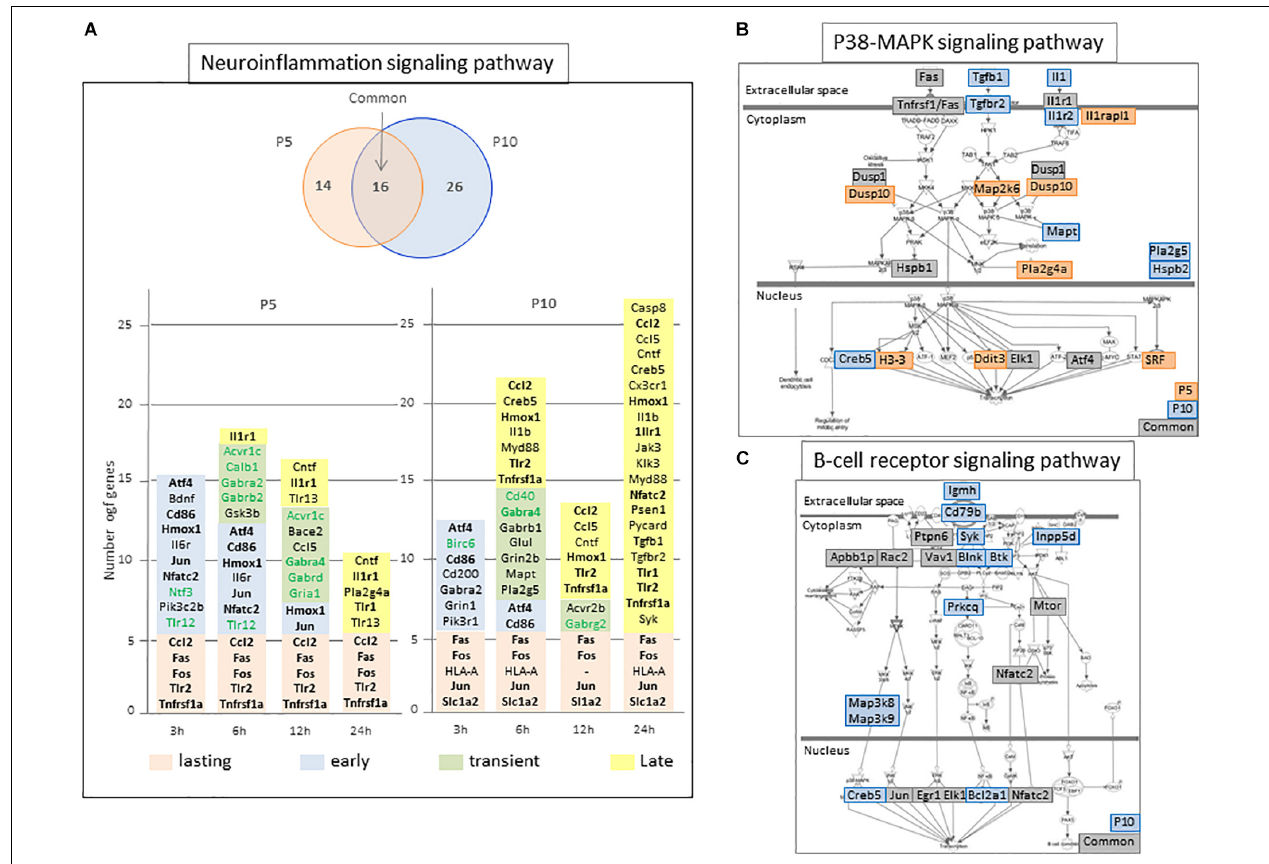
FIGURE 5 | Schematic representation of selected P5 and/or P10 enriched pathways. (A) “Neuroinflammation signaling pathway” representation of age-specific and common numbers of genes affected in the pathway at P5 (orange circle) and/or P10 (blue circle). Genes contributing to enrichment, induced or repressed (green characters) were indicated at the different time points they were detected. Colored backgrounds refer to their regulation kinetics. Bold characters indicate genes identified in both P5 and P10 brains. (B,C) Schematic representation of Ingenuity pathways enriched at P5 and P10 (B; P38-MAP signaling) or P10 only ( C ; B-lymphocyte signaling). The genes detected to enrich the pathways are indicated on age dependent colored